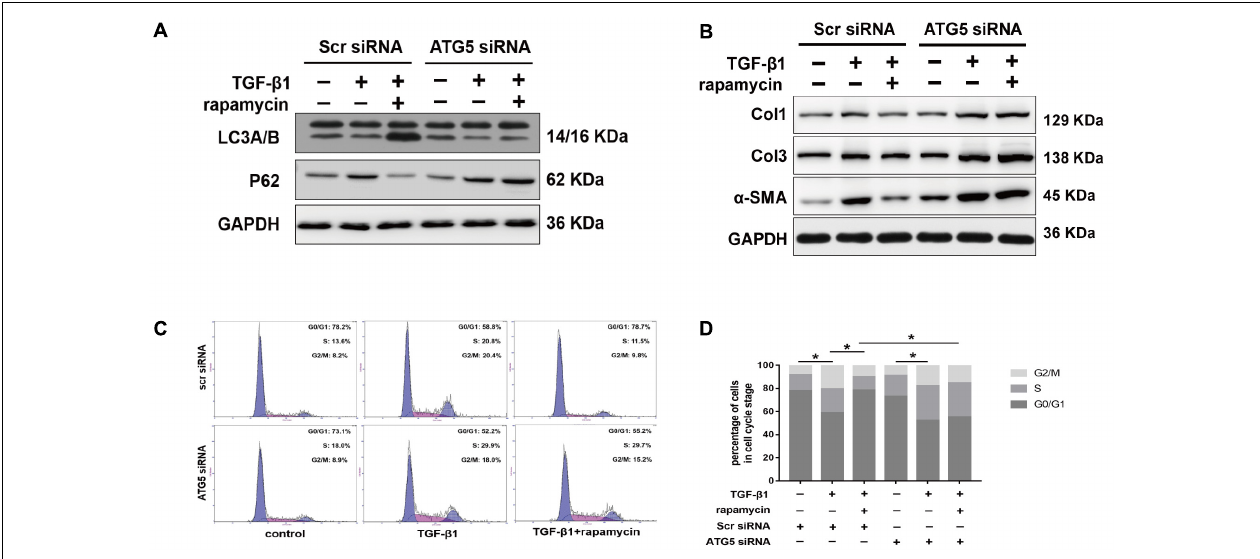
FIGURE 11 | Autophagy inhibition by Atg5 siRNA abolishes the protective effects of rapamycin in fibroblasts. Fibroblasts were transfected with Scramble or Atg5 siRNA before further treatments. (A) Representative images of western blot analysis of LC3A/B and p62 after treated with TGF- β 1 and/or rapamycin for 24 h. (B) Representative images of western blot analysis of Col1, Col3, and α -SMA after different treatments. (C) Representative images of flow cytometry and (D) quantitative analysis of cell cycle distribution after different treatments. The data are shown as the means ± SD of three independent experiments. ∗ P < 0.05.